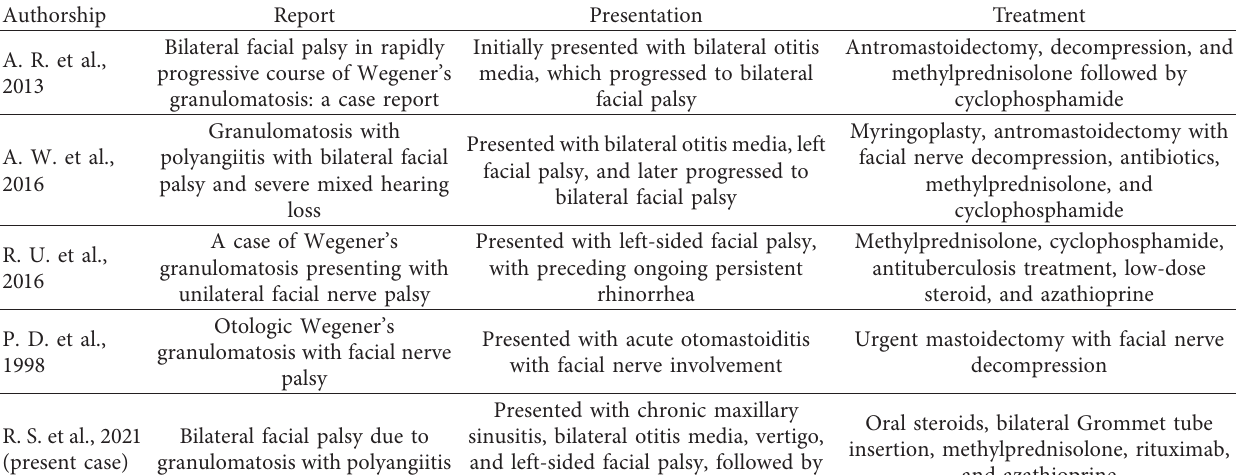
Table 1: Comparison of similar reported cases in the